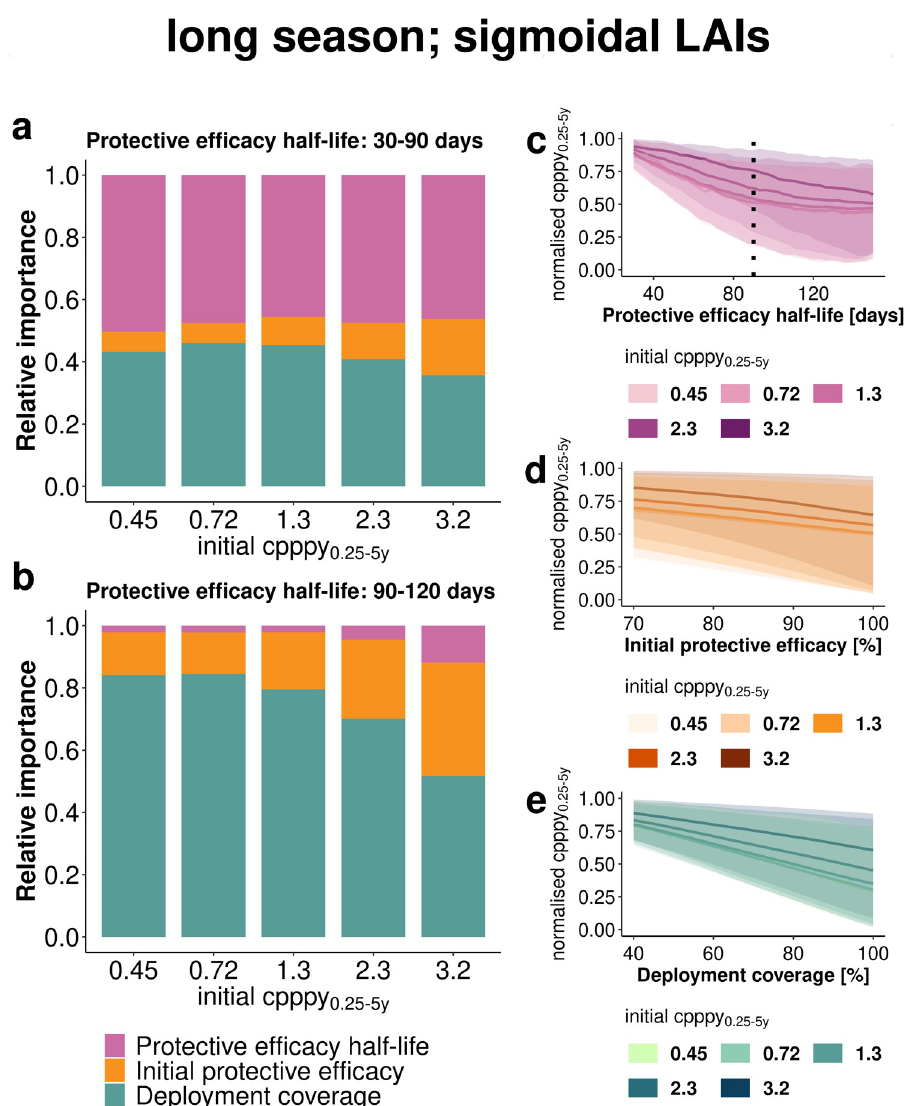
Fig 4. Estimated importance of LAI properties and operational factors on the level of clinical incidence reduction. Results are shown for the implementation stage for sigmoidal LAIs in a setting with low access to care and long malaria transmission season. (a, b) Sobol sensitivity analysis estimates the relative importance of LAI coverage, initial protective efficacy and half-life of protective efficacy to the variance of the emulator through decomposition of variance over the entire evaluated parameter space (coverage 40–100%, initial protective efficacy 70–100% and half-life (a) 30–90 days and (b) 90–150 days). Changes in clinical incidence measured as cases per person per year 0.25-5y with increasing tool properties or deployment coverage across the parameter space are shown for (c) half-life (30–150 days), (d) initial protective efficacy (70–100%) and (e) coverage (40–100%). The lines represent the mean and the 95% confidence interval (shaded area) capture the distribution of incidence reduction across all sampled values. The dotted line in panel c indicates the split of half-life range for sensitivity analysis in panels a and b. Increasing color intensity represents increasing initial cases per person per year 0.25-5y . Further results for different decay shapes and length of transmission season are shown in the Figs D and E in S1 Text. impact of sigmoidal LAIs with increasing protective efficacy half-life (shown in Fig 4A and 4D for a half-life threshold of 90 days). For instance, if the LAI half-life was less than 90 days (Fig 4A), the protective efficacy half-life and deployment coverage shared almost equal propor- tions of attributable variance, accounting for 38% to 52% of variance while the initial